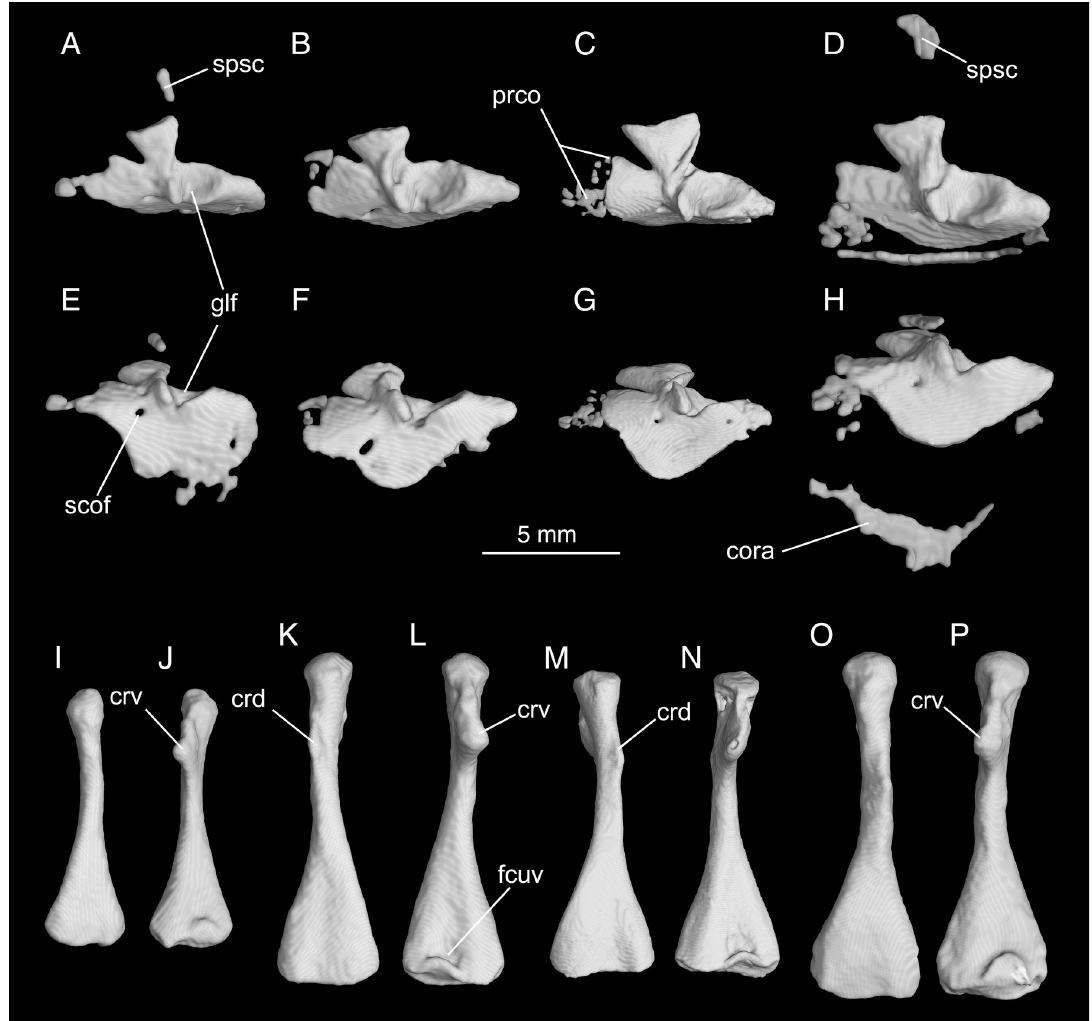
Fig 9. Micro-CT rendered reconstructions of the pectoral girdle and upper arm of Batrachuperus yenyuanensis . Left scapulocoracoid of CIB 94631 (A, E), CIB 16999 (B, F), CIB 17308 (C, G), CIB 72599 (D, H) in lateral (upper row) and ventrolateral (middle row) views; left humerus of CIB 94631 (I, J), CIB 17308 (M, N), CIB 72599 (O, P) and right humerus of CIB 16999 (K, L) in lateral (left) and medial (right) views. CIB 16999 from Shenguozhuang, Yuexi County; CIB 17308 from Shuangertang, Yanyuan County; CIB 72599 from Tuowu, Mianning County; CIB 94631 from Xieka, Jiulong County. ventral crest of the humerus when the arm swings forward. The coracoid plate is expanded both antero-posteriorly and ventrally, and is slightly curved medially. The ventral border of the plate is grooved for articulation with the cartilaginous part of the coracoid. A large foramen supracoracoideum penetrates the coracoid plate anteroventral to the glenoid fossa, serving for passage of the nervus supracoracoideus and the associated vessels [24]. In addition to the co- ossified scapulocoracoid, extra-ossification of normally the cartilaginous suprascapular, pro- coracoid and coracoid regions is observed in several specimens (Fig 9A–9H). The humerus is straight and fairly robust, with a short and narrow shaft, but strongly expanded proximal and distal ends (Fig 9I–9P). Proximally, the humeral head merges with a large and triangular ventral crest (crista ventralis humeri), onto which the MM. pectoralis and supracoracoideus attach [24]. Also at the proximal end, a short trochlear groove on the flexor